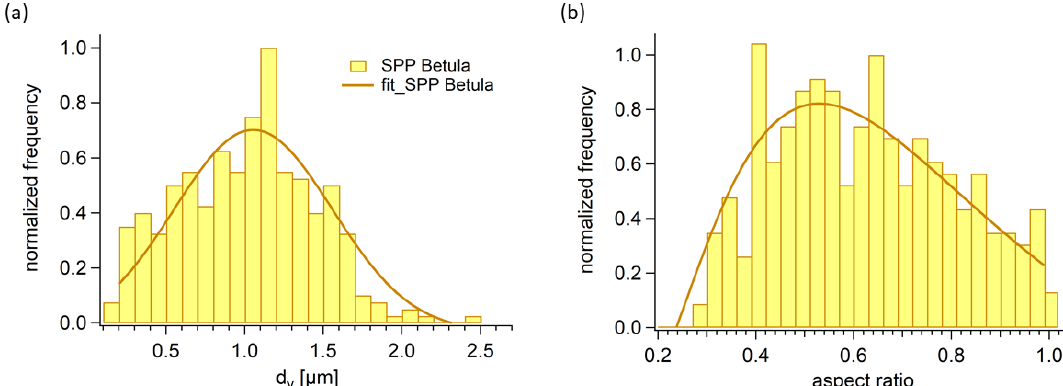
Figure 5. (a) Size distribution of SPPs. The volume equivalent diameter d v was calculated by Eq. (1), which is based on the approximated shape of an SPP. The d v of 326 SPPs was binned into 24 equidistant intervals between 0.2 and 2.5µm and normalized to the interval with the maximum number of SPPs. (b) Aspect ratio of